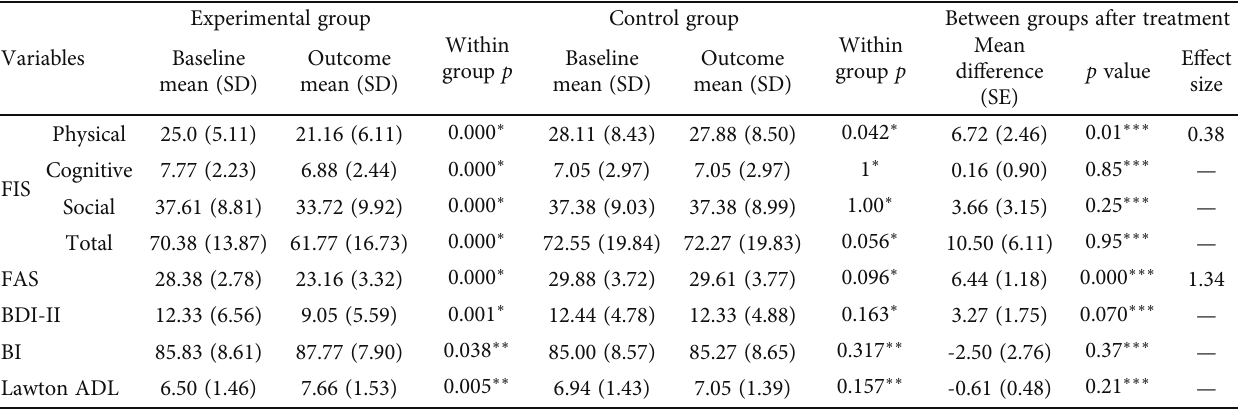
Table 2: The within-group and between-group analyses of the Fatigue Impact Scale, Fatigue Assessment Scale, Beck Depression Inventory- II, Barthel Index, and Lawton ADL Scale in two groups, the experimental group (16 patients received vestibular rehabilitation interventions) and the control group (16 patients received conventional rehabilitation